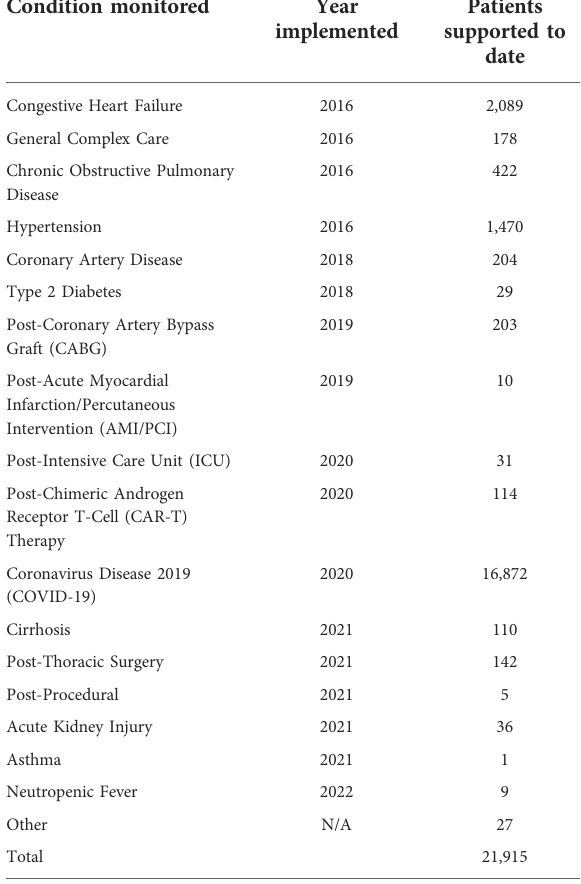
TABLE 3 Patients monitored per program, from RPM inception (2016) through September